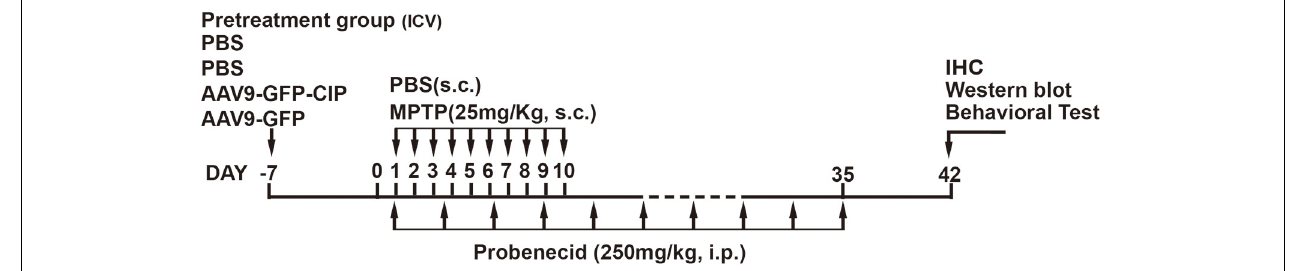
FIGURE 1 | Schematic chart of drug treatments in mice. Forty-eight mice were randomized into four treatment groups with 12 mice in each group, including (1) control group, PBS; (2) PBS group, PBS pretreatment + MPTP/p insult; (3) GFP group, AAV9-GFP pretreatment + MPTP/p insult; and (4) CIP group, AAV9-GFP-CIP pretreatment + MPTP/p insult. The animals were pre-treated with PBS, AAV9-GFP, and AAV9-GFP-CIP 7 days before initiation of MPTP/p insult. Then behavioral test, western blot, and IHC analysis were performed on day 42. MPTP/p,